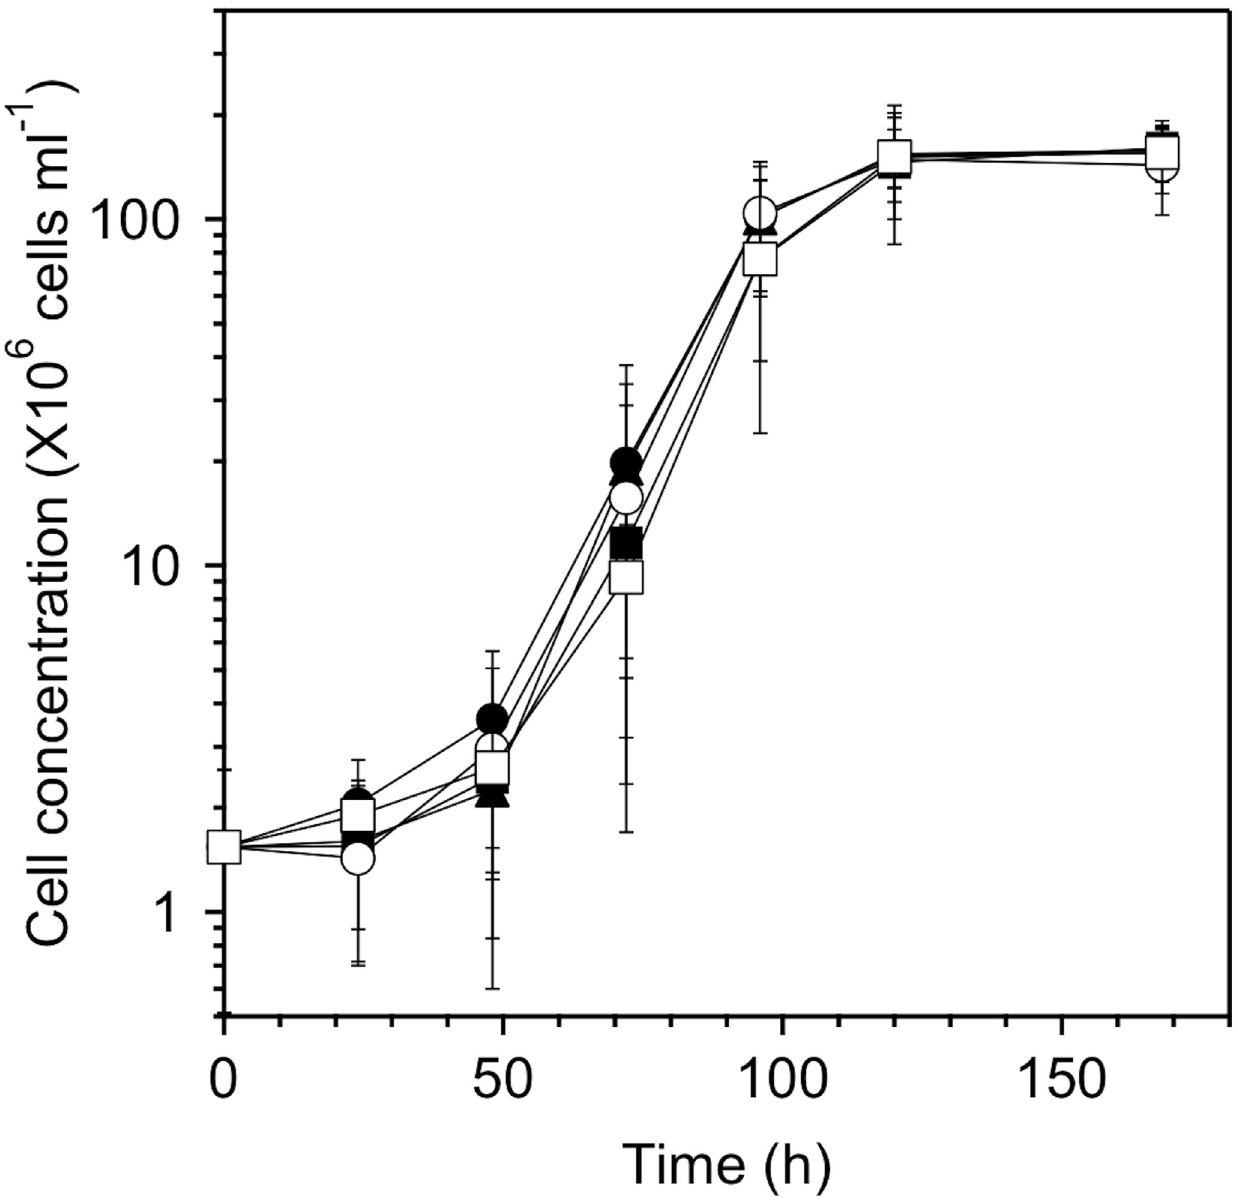
Fig 1. Effect of PEGs added to the culture medium on the growth of M . magnetotacticum MS-1. The cell concentration was evaluated, counting directly the number of cells in the culture medium using a Bacteria Counting Chamber. The closed circles, squares and triangles, and open circles and squares, respectively, correspond to the growth curves in the absence of PEG and in the presence of PEG200, PEG6,000, PEG20,000, and PEG500,000. The average values were calculated from three independent experiments. The error bars represent the standard